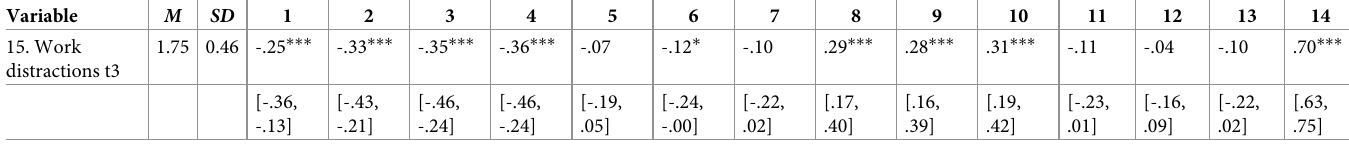
development over time To test whether individual differences in trait self-control at baseline can explain different trends in the outcome variables over time, we estimated a series of models including the mea- sure of baseline self-control, time and the interaction time × baseline self-control. The results are presented in Table 4. Performance. We detected a significant negative interaction effect between time and self-